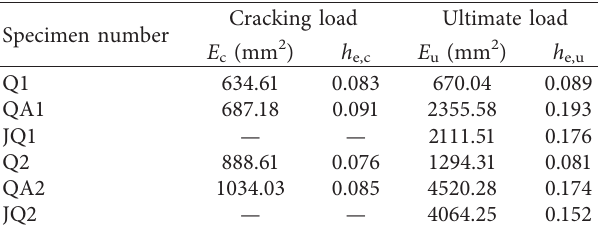
Figure 8: Calculating graph of E and h Table 5: Energy dissipation capacity of specimens. Specimen